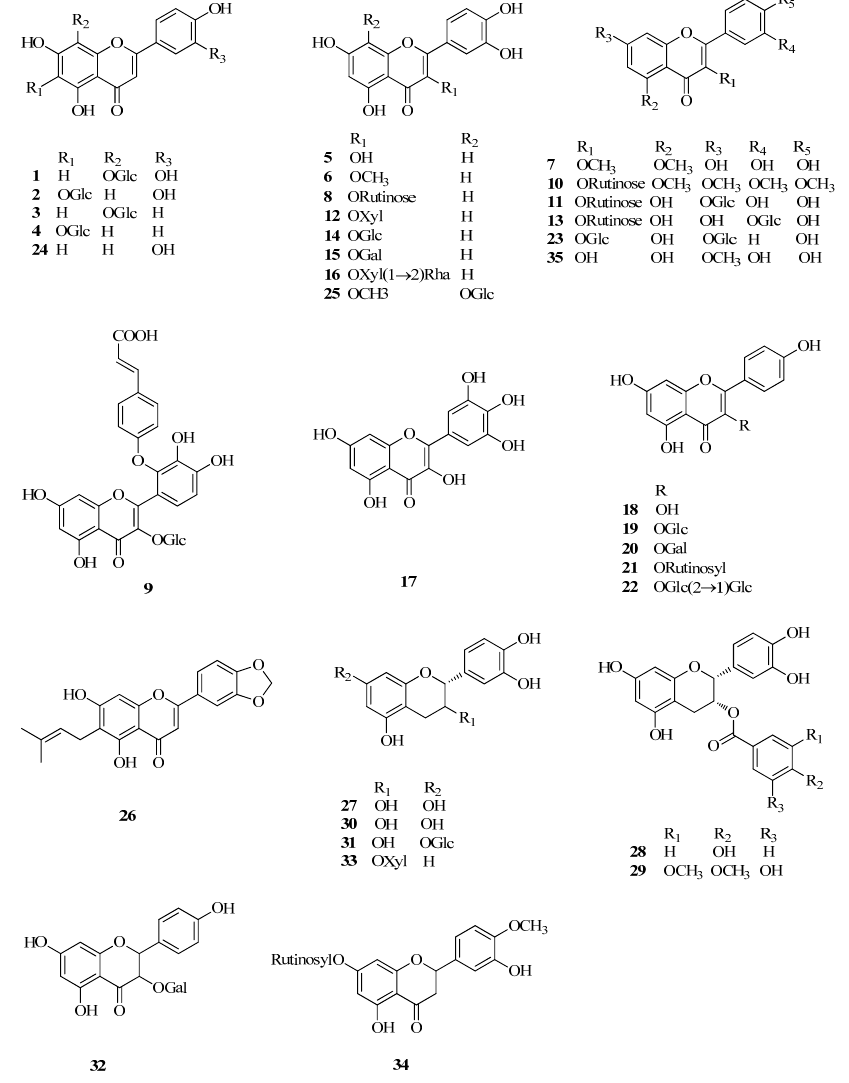
Figure 1. Structures of flavonoids isolated from Fagopyrum esculentum ( F. esculentum ), Fagopyrum tataricum ( F. tataricum ) and Fagopyrum dibotrys ( F. dibotrys ).